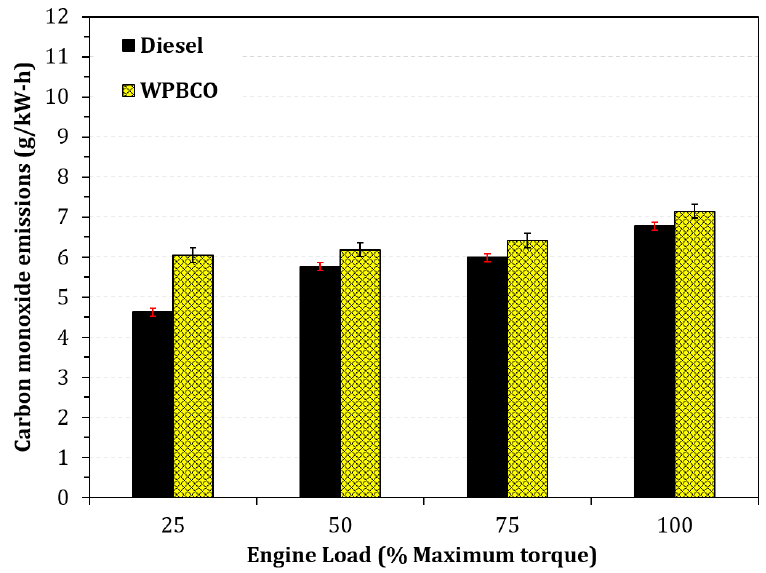
Figure 11. Variation in carbon monoxide emissions with respect to the engine load.